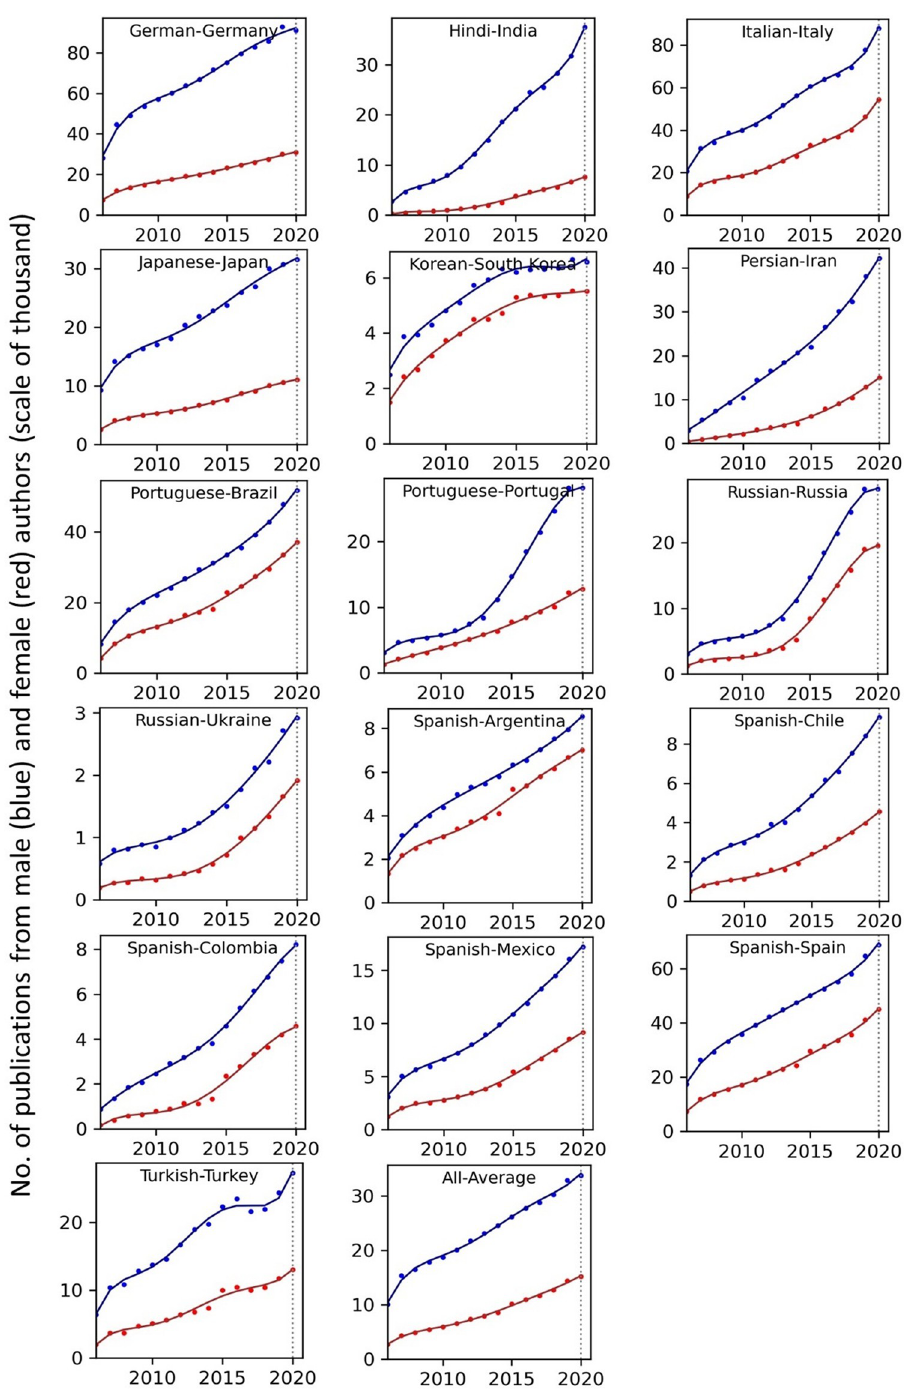
Fig 16. Temporal trends in male (blue lines) and female (red lines) total research productivity based on A-Z method (part 2).